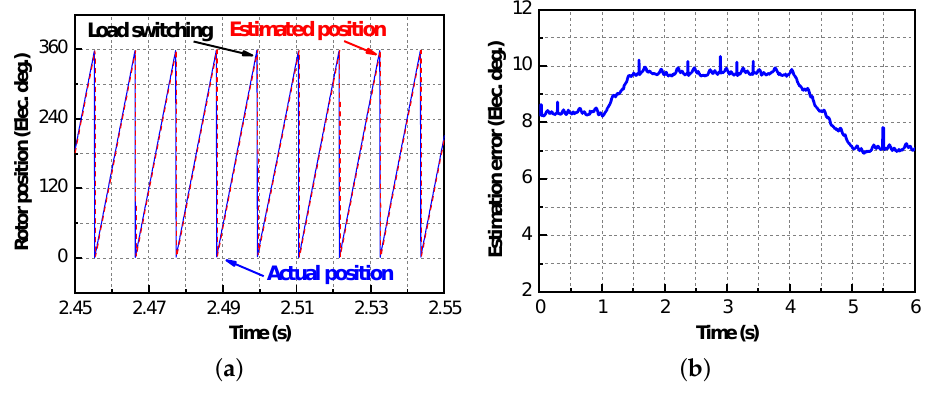
Figure 26. Experimental results.( a ) Rotor position and ( b ) estimation